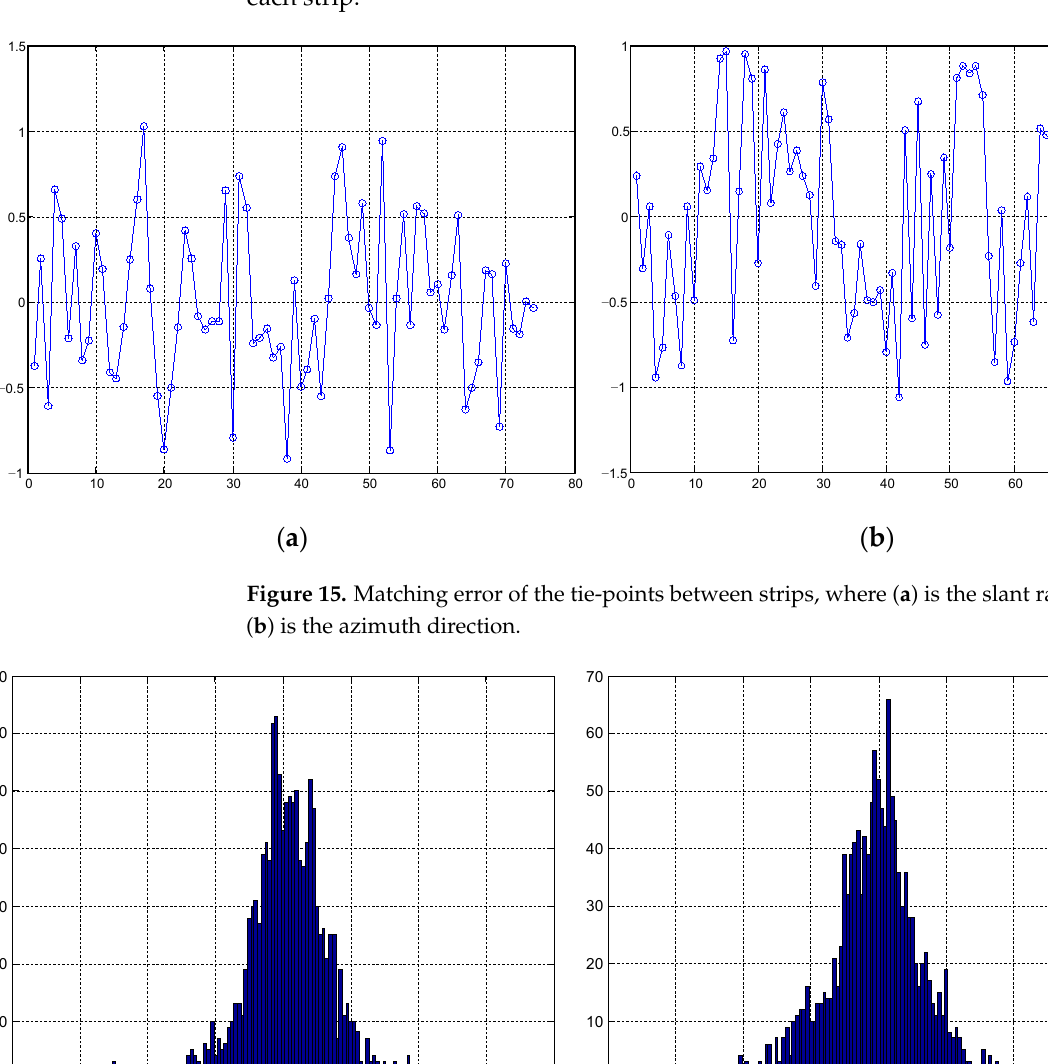
Figure 15. Matching error of the tie-points between strips, where ( a ) is the slant range direction and ( b ) is the azimuth direction.